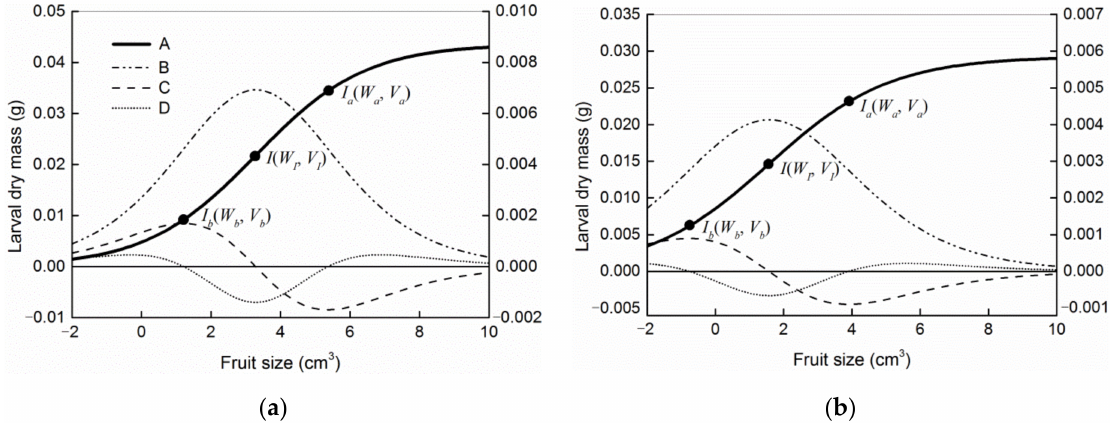
Figure 6. Dynamic characteristics of the marginal effect of C. styracis larval development: ( a ) C . oleifera ; ( b ) C . meiocarpa . A, logistic model; B, marginal effect (d W /d V ); C, first derivative of marginal effect; D, second derivative of marginal effect. I ( W I , V I ), the inflexion point of the logistic model; I b ( W b , V b ), the critical point (before the inflexion point) between the slow change stage and fast change stage of marginal effect; I a ( W a , V a ), the critical point (after the inflexion point) between the fast change stage and asymptotic change stage of marginal